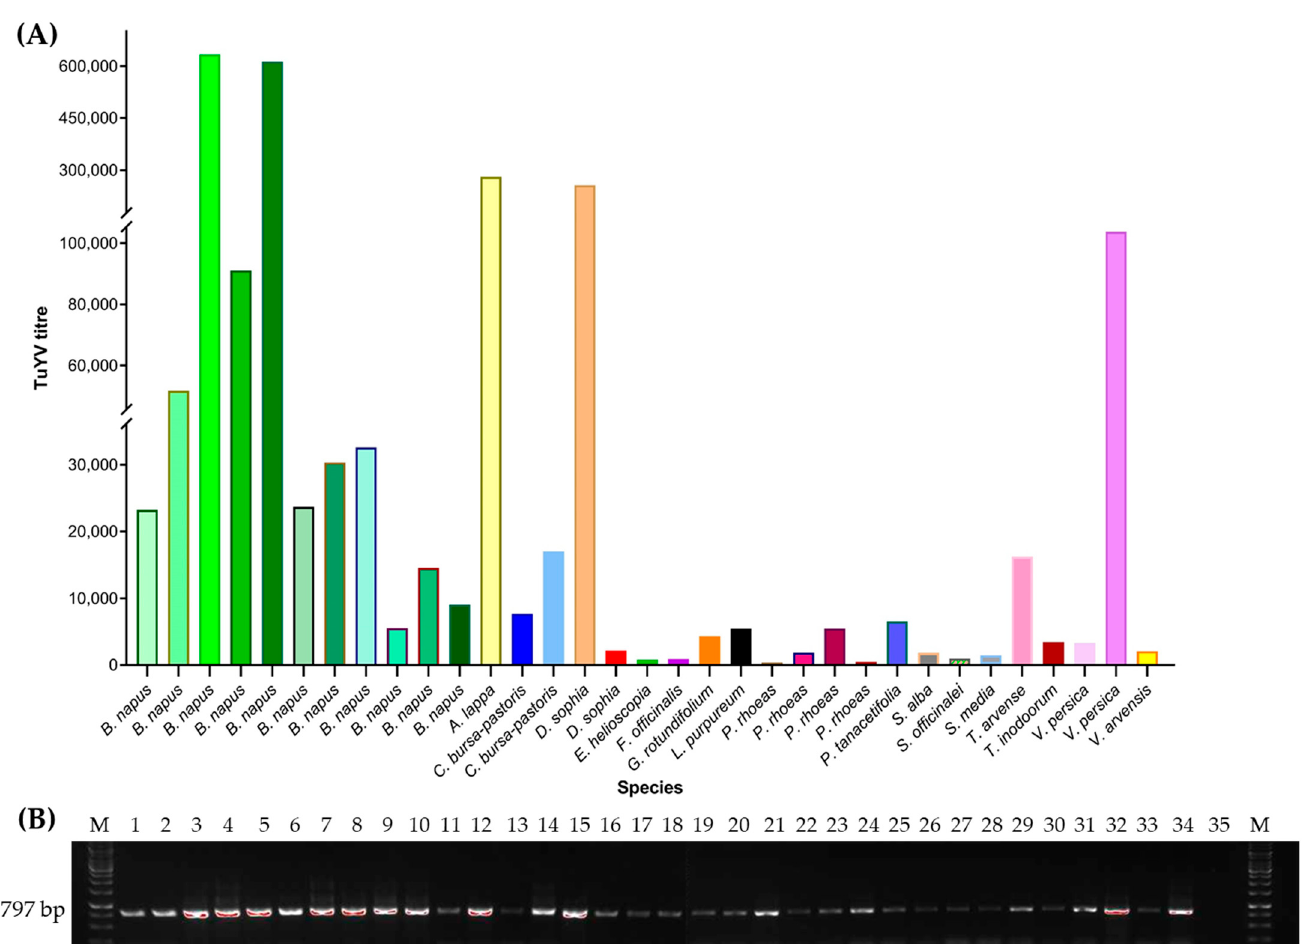
Figure 4. ( A ). TuYV titre detected in RT-PCR-positive plants of oilseed rape, intercrop and weed species by RT-qPCR. ( B ). TuYV detection by RT-PCR using the primer pair TuYV_5cpF/TuYVR-K2, 797 bp (lanes 1–33, representing the same samples as in Figure A {from left to right}; lanes 34 and 35 positive and negative control, respectively; lane M GeneRuler 1 kb DNA ladder, Thermo fisher Scientific, Wilmington, DE, USA).